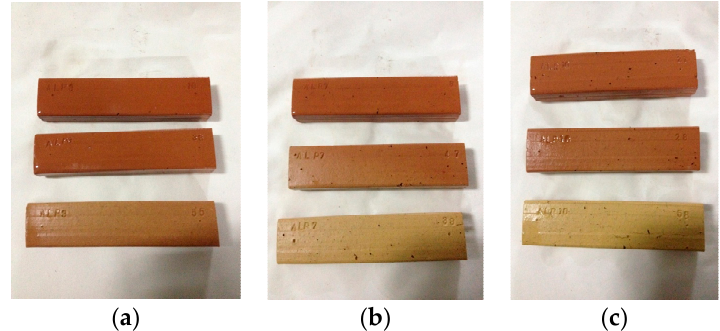
Figure 10. Pieces ALP 3% ( a ), 7% ( b ), and 10% ( c ) at 850 °C, 950 °C, and 1050 °C after the 25th freezing- thawing cycle.